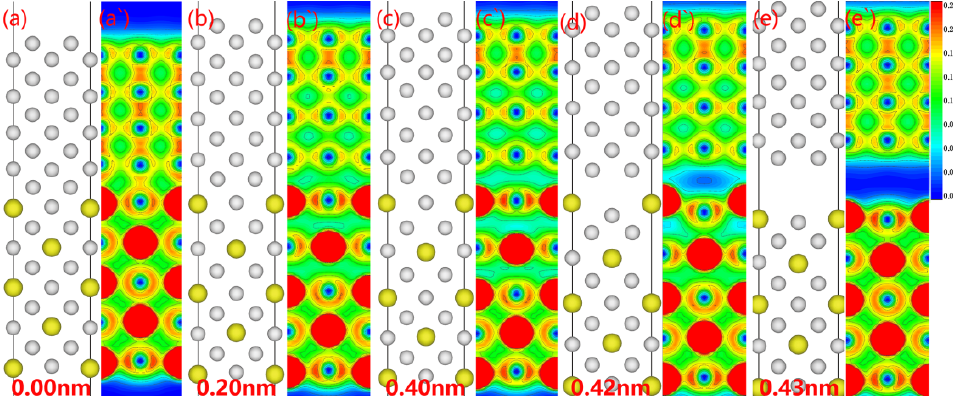
Figure 10. Fracture behavior and corresponding electron density of stretched Al 3 Y(110)|Al(110) system: ( a – e ) atomic site of the interface system, ( a` – e` ) electron density of the interface. system: ( a – e ) atomic site of the interface system, ( a‘ – e‘ ) electron density of the interface.